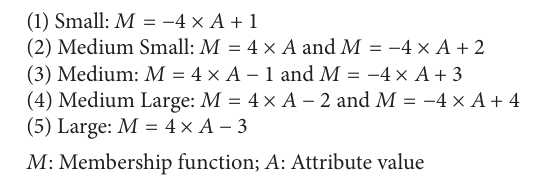
Algorithm 1: The antecedent fuzzy set equations used in this paper.